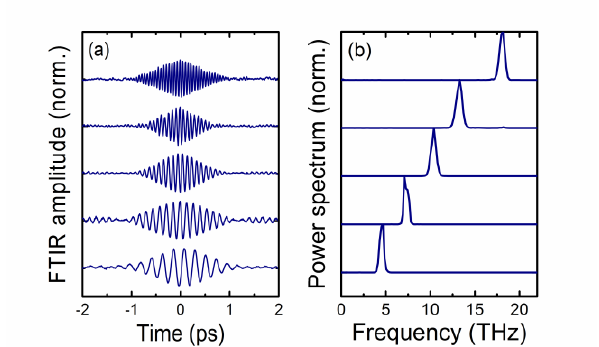
Fig.2. Normalized (a) FTIR interferograms and (b) corresponding Fourier transformations of THz transient electric fields, tuned by changing the difference frequency between the two linearly-chirped near-IR